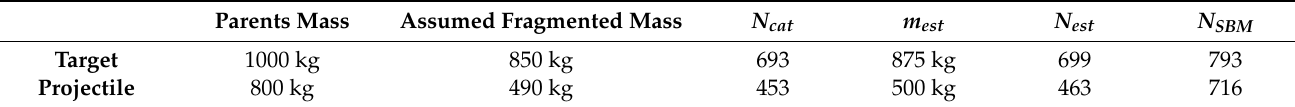
Table 3. Comparison between standard-SBM and iterative-SBM for first test